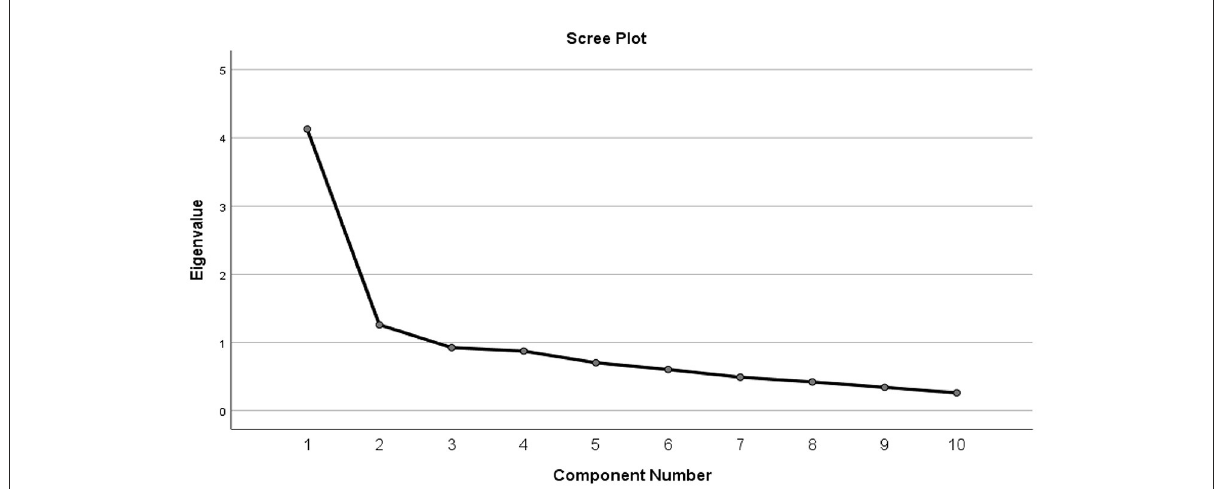
FIGURE1 Scree plot for the principal component analysis of the Scale of the State of School Culture